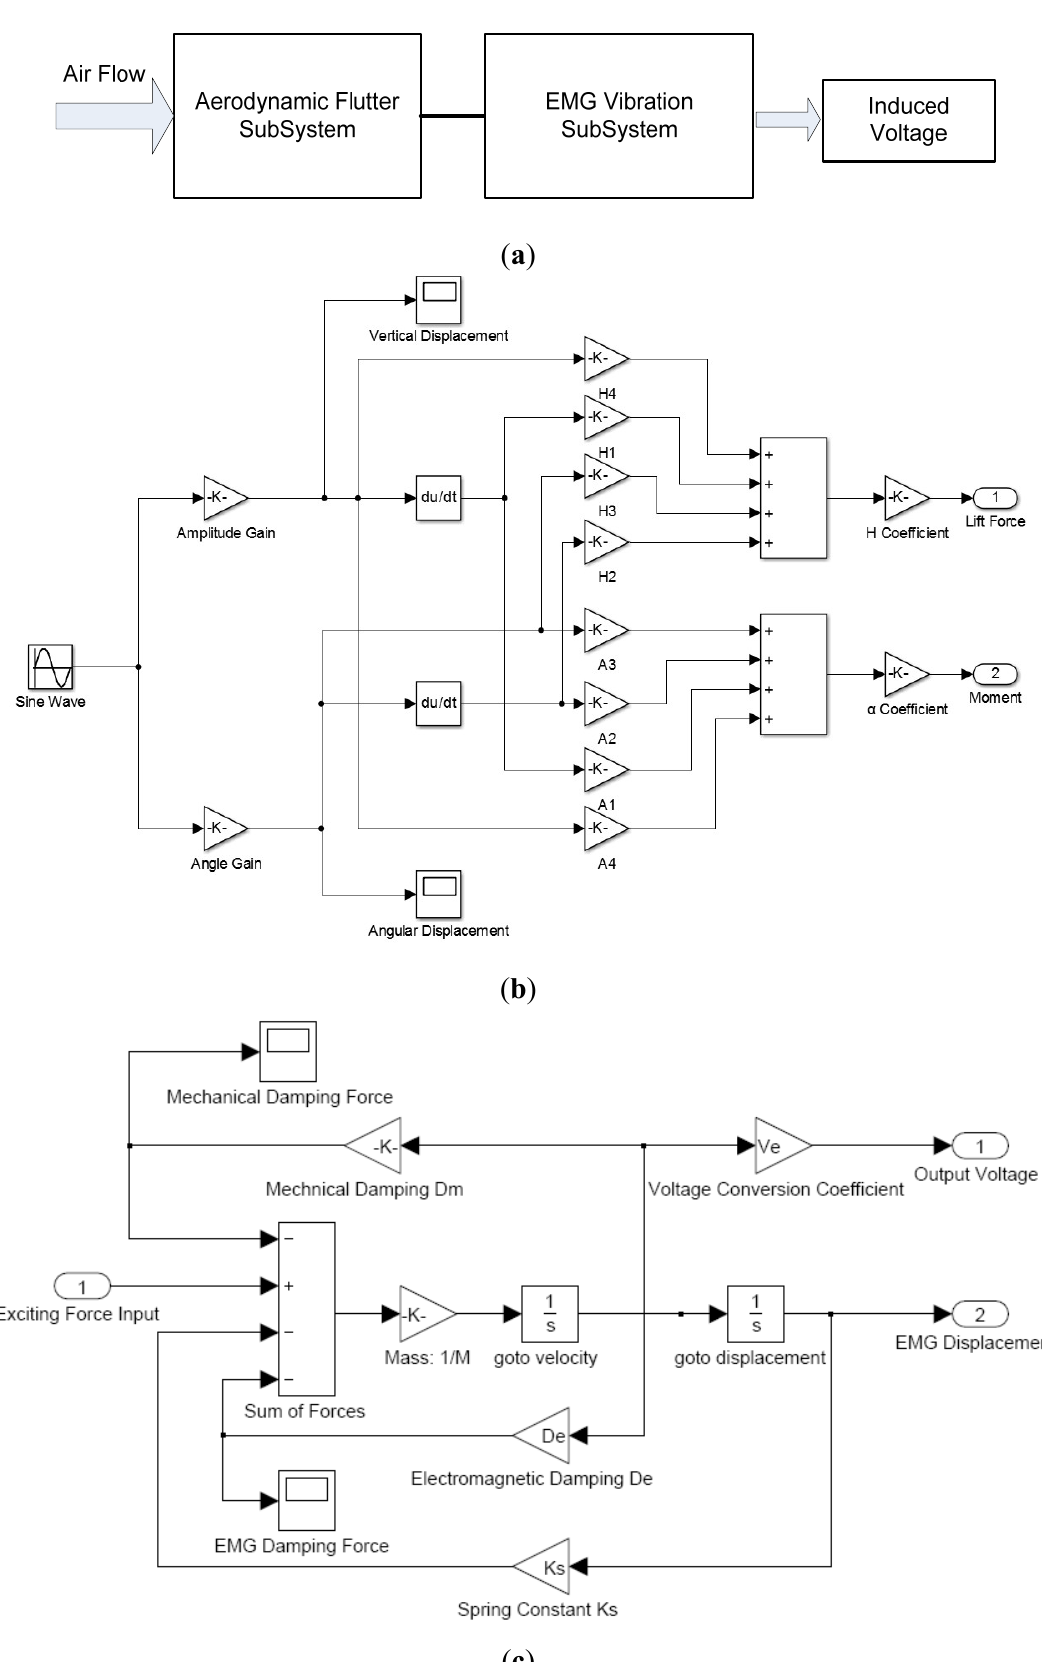
Figure 9. ( a ) Flow chart of flutter energy conversion system; ( b ) Aerodynamic flutter subsystem; ( c ) Electromagnetic generator (EMG)